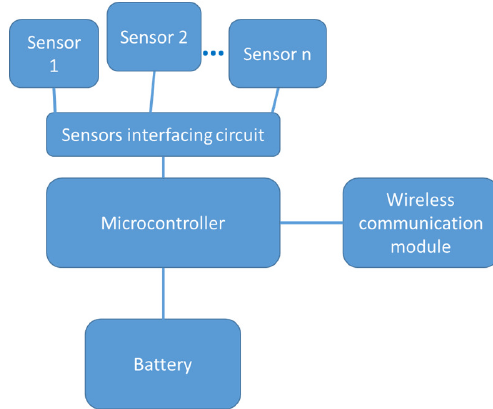
Figure 3. WSNs node architecture and components.